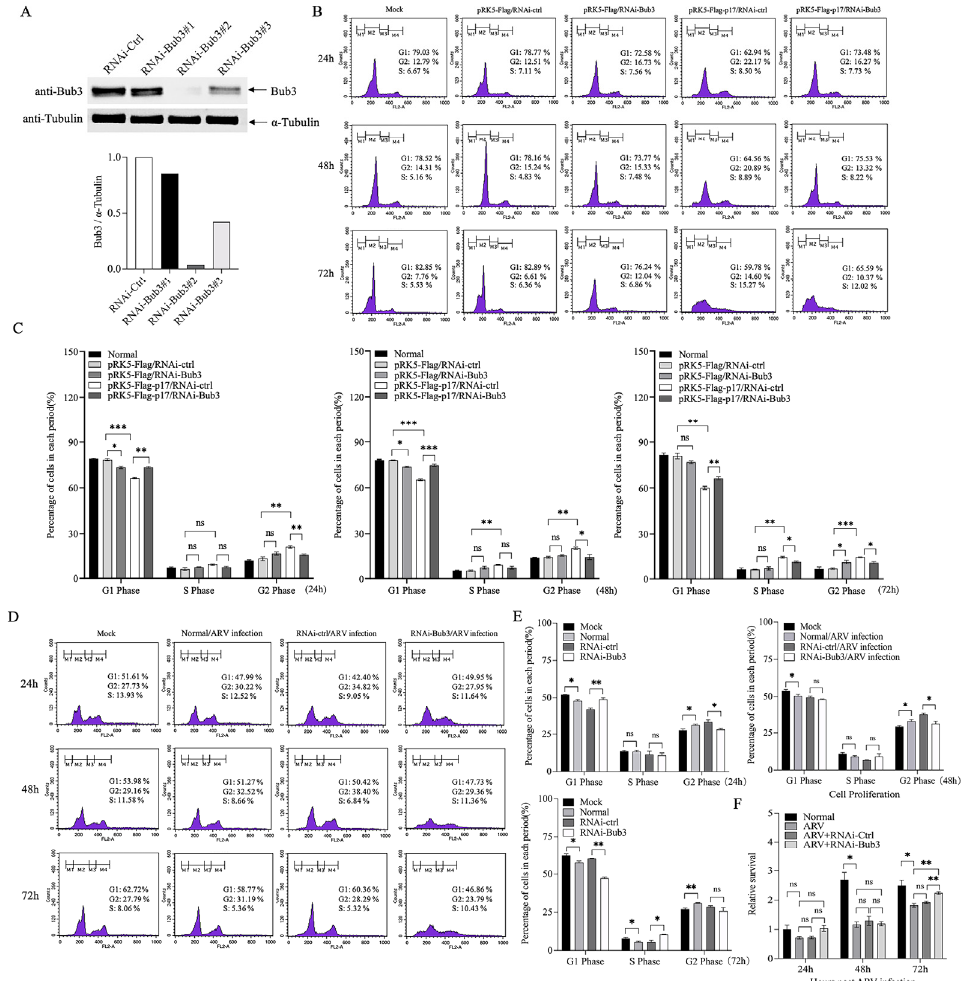
Figure 4. Bub3 is required for ARV-induced cell-cycle arrest. ( A ) Effects of Bub3 RNAi on the expression of endogenous Bub3. Vero-E6 cells were transfected with siRNA (RNAi#1–3) or controls. Twenty-four hours after transfection, cell lysates were prepared and examined by Western Blot using an anti-Bub3 antibody. Endogenous α -Tubulin expression was examined as an internal control, and the relative levels of Bub3 were calculated as follows: band density of Bub3 / that of α -Tubulin. ( B ) Knockdown of Bub3 attenuated cell-cycle arrest in cells with overexpression of p17. Vero-E6 cells were transfected with RNAi-Bub3 or controls, followed by transfection with pRK5-Flag-p17 or empty vector. At different time points (24 h, 48 h and 72 h) after p17 overexpression, cell-cycle changes were analyzed by flow cytometry. ( C ) The percentage of all period cells in ( B ) was quantified. * stands for p < 0.05, ** stands for p < 0.01 and *** stands for p < 0.001. ( D ) Knockdown of Bub3 attenuated cell-cycle arrest in ARV-infected cells. Vero-E6 cells were transfected with siRNA or controls, followed by infection with ARV at an MOI of 1. At different time points (24 h, 48 h and 72 h) after ARV infection, cell-cycle changes were analyzed by flow cytometry. ( E ) The percentage of all period cells in (D) was quantified. * stands for p < 0.05, ** stands for p < 0.01 and *** stands for p < 0.001. ( F ) Knockdown of Bub3 restored the cell proliferation inhibited by ARV infection. Vero-E6 cells were transfected with siRNA or controls, followed by infection with ARV at an MOI of 1. At different time points (24 h, 48 h and 72 h) post ARV infection, the cell proliferation was analyzed with MTT. * stands for p < 0.05, ** stands for p < 0.01 and *** stands for p < 0.001.